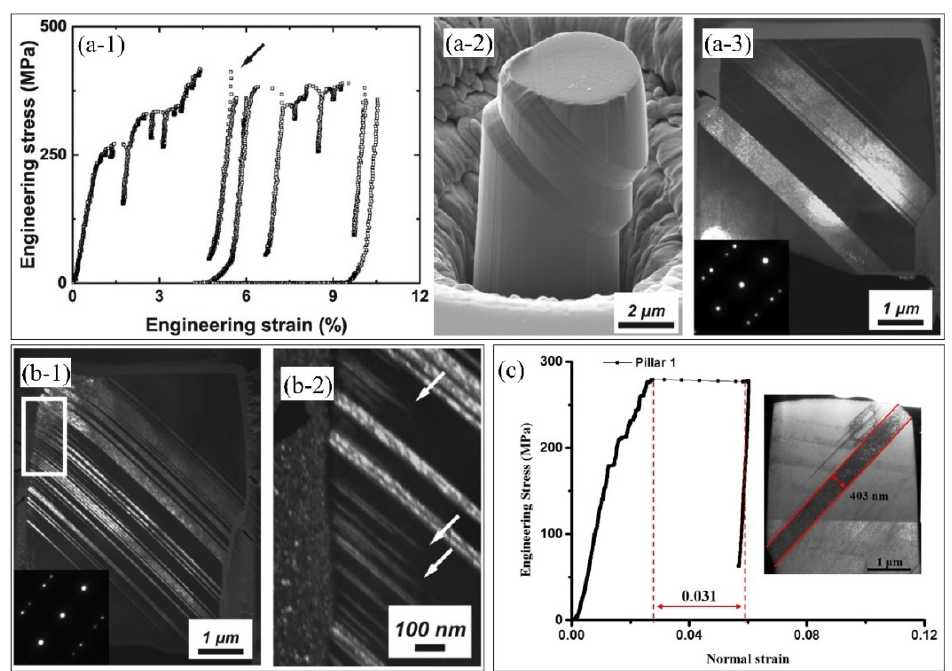
Figure 10. ( a-1 ) The engineering stress–strain curve of micro-pillar compression test of TWIP steel (Fe-22Mn-0.6C in wt.%). ( a-2 ) SEM image showing the deformed morphology of micro-pillar. ( a-3 ) TEM image showing the presence of large deformation twins in deformed micro-pillar. ( b-1 ) The TEM images show the presence of intensive deformation twins in another deformed micro-pillar of the same steel [74]. ( b-2 ) Magnified view of the rectangle in ( b-1 ). Reprinted with permission from ref. [74]. Copyright 2017, Elsevier. ( c ) The engineering stress–strain curve and deformation twins in another study [70]. Reprinted with permission from ref. [70]. Copyright 2015, Elsevier.